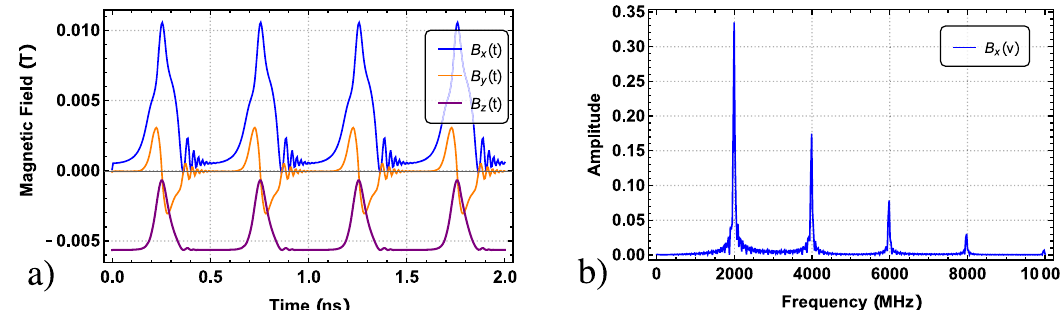
Fig. 4 Nanomagnet driven at 2 GHz. a Induced magnetic fi eld ( B x , B y , B z ) in the qubit volume in time domain, and b in frequency